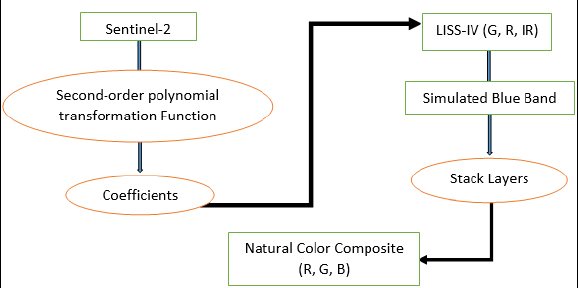
Figure 1: Flow chart of methodology adopted in this research .